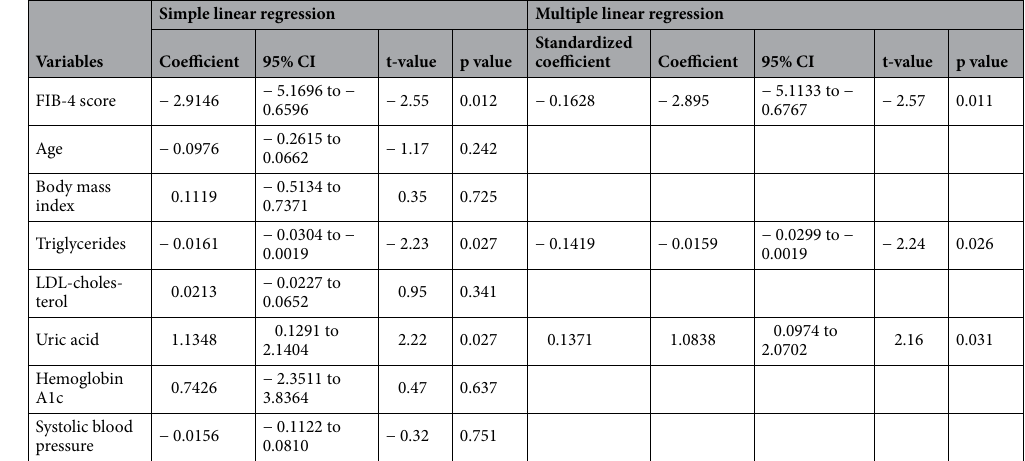
Table 2. Linear regression analysis with the rate of change in eGFR as dependent variables in participants without specific metabolic abnormal. N = 237; Model adjusted R 2 , 0.055; Model F, 5.55; P = 0.0011; Rate of change in eGFR = (eGFR 2014 − eGFR 2009 )/eGFR 2009 . Metabolic factors included body mass index ≥ 25.0 kg/m 2 , hypertension (defined as systolic blood pressure ≥ 140 mmHg, diastolic blood pressure ≥ 90 mmHg, and/or the use of antihypertensive medication), or daily smoking habits. eGFR estimated glomerular filtration rate, LDL low-density